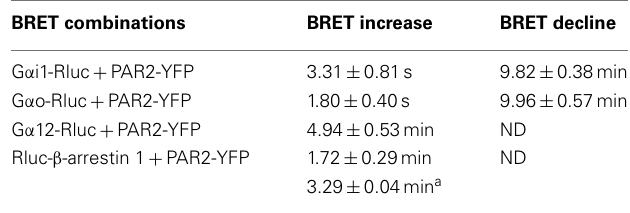
Table 1 | t 1/2 Values of trypsin-induced BRET increase signals and its